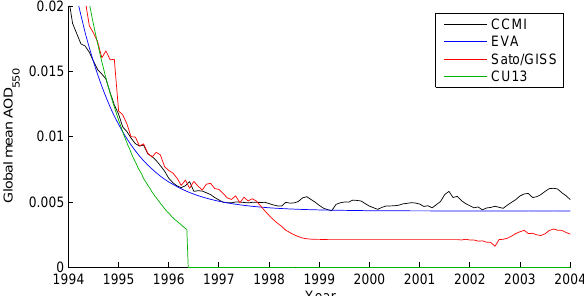
Figure 10. Global mean AOD for the 1994–2004 period from the EVA single-box approach and the CCMI, Sato/GISS, and CU13 re-